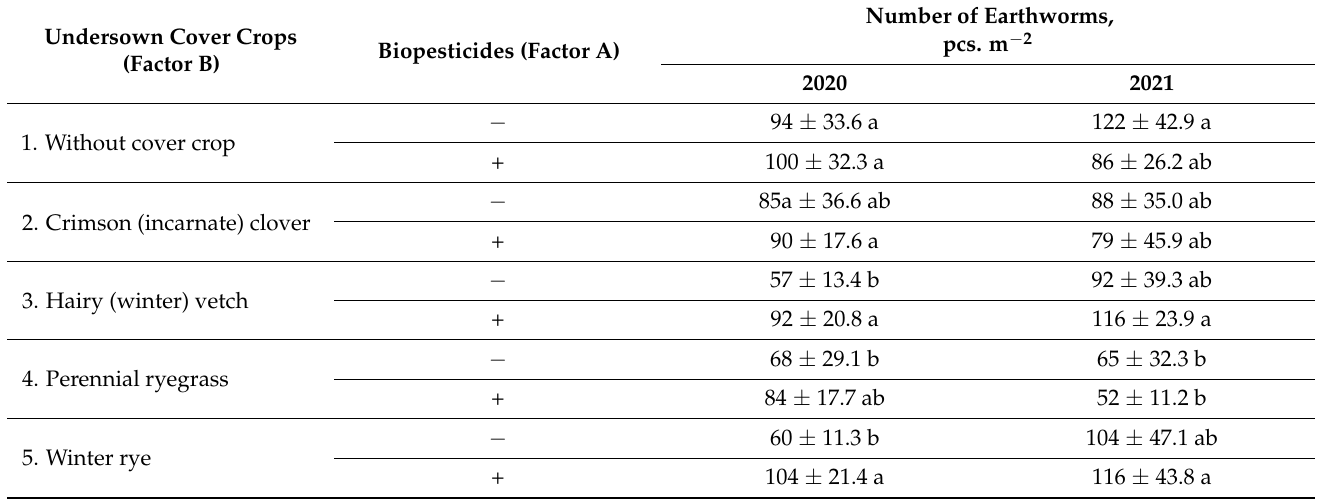
Table 3. Number of earthworms.